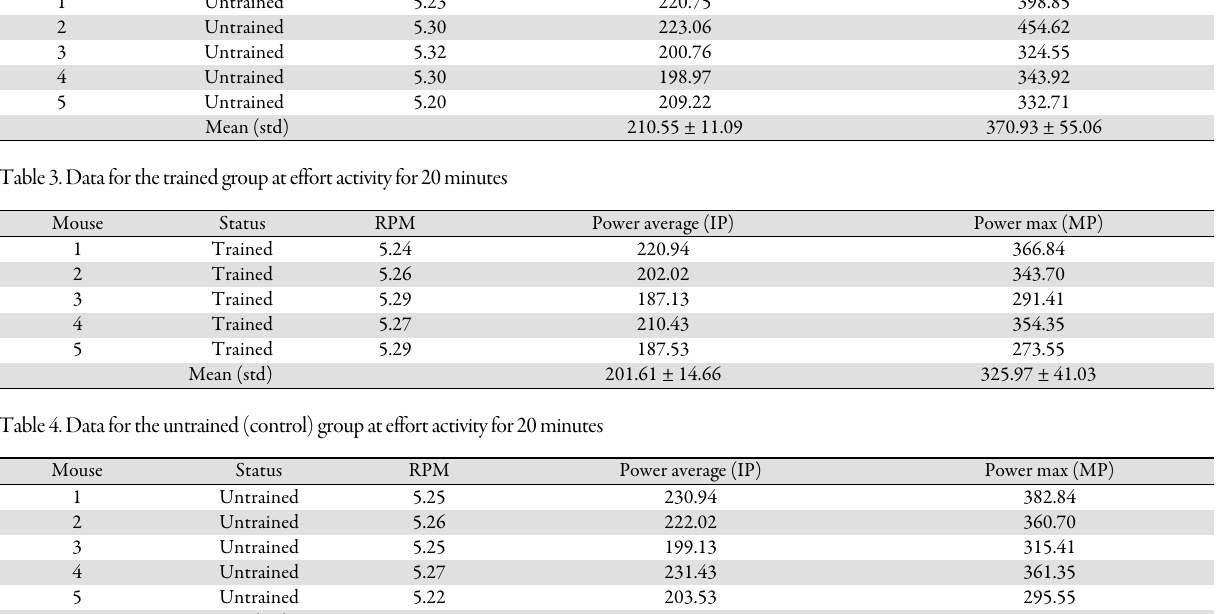
Table 2. Data for the untrained (control) group at effort activity for 5 minutes Mouse